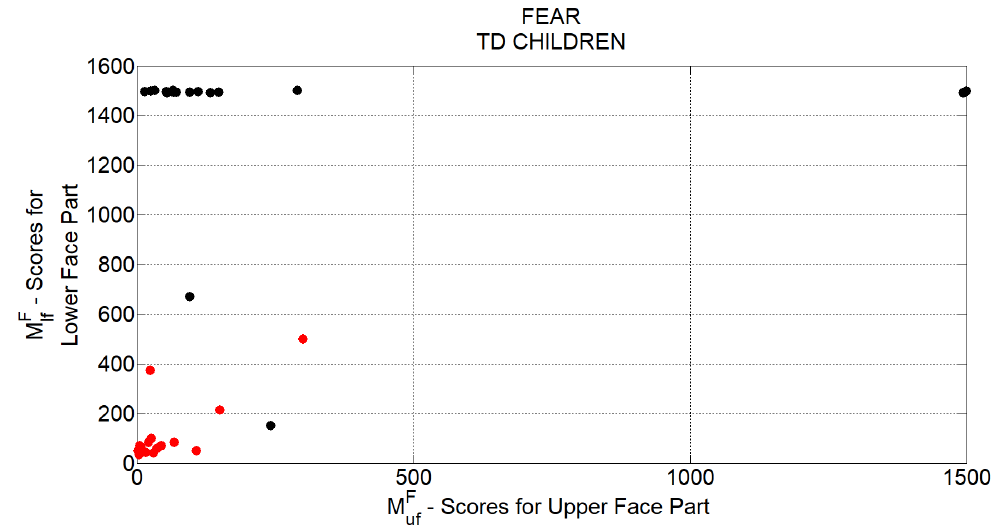
Figure 4. Scores computed for the production of Fear expressions by TD children.